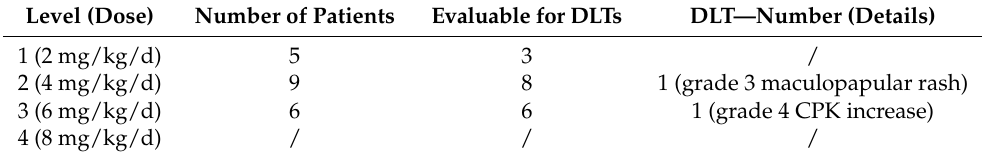
Table 3. Number of patients per fluvastatin dose levels and DLTs. Level (Dose) Number of Patients Evaluable for DLTs